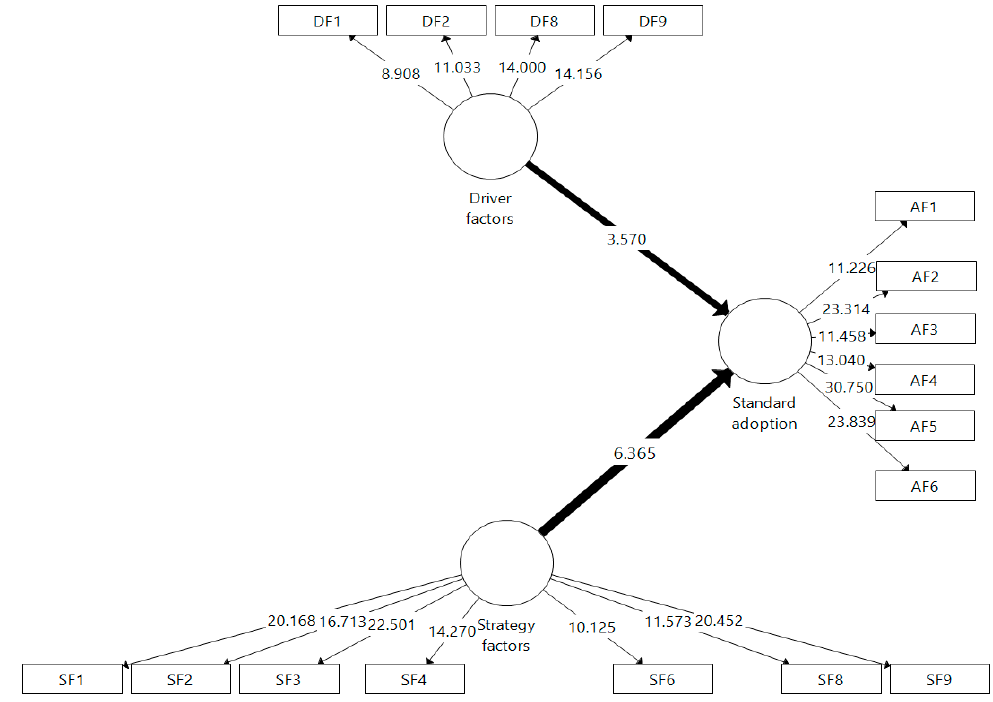
Figure 6. Path analysis of the research hypotheses.